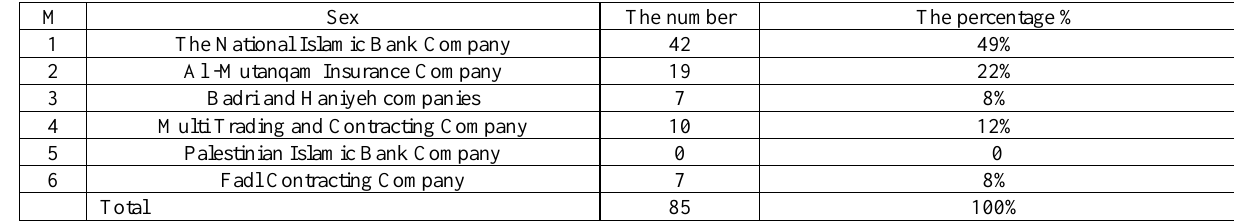
Table 1. Distribution of members of the study sample, according to the organization